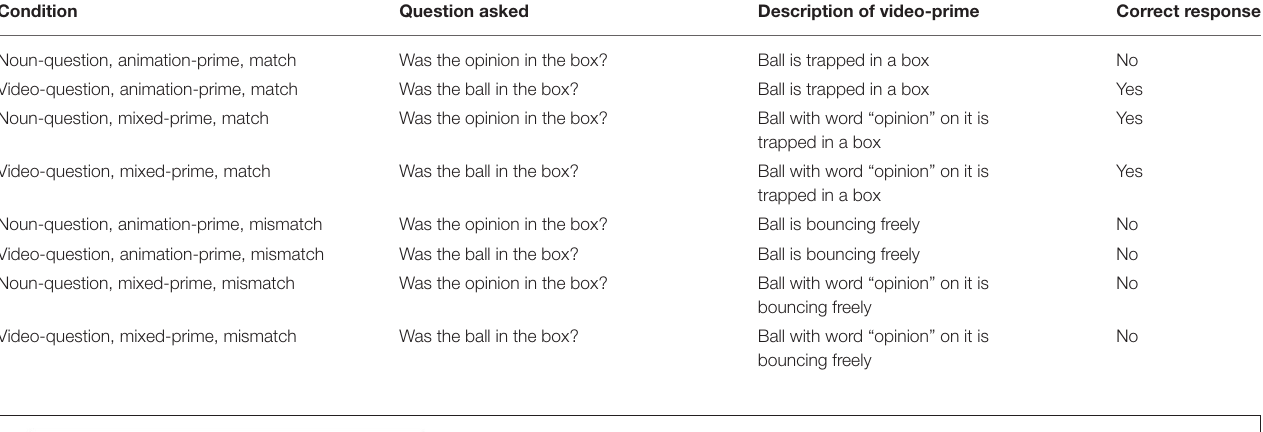
TABLE 1 | Description of all conditions for the question-response times in Experiments 1, 2, and 3.